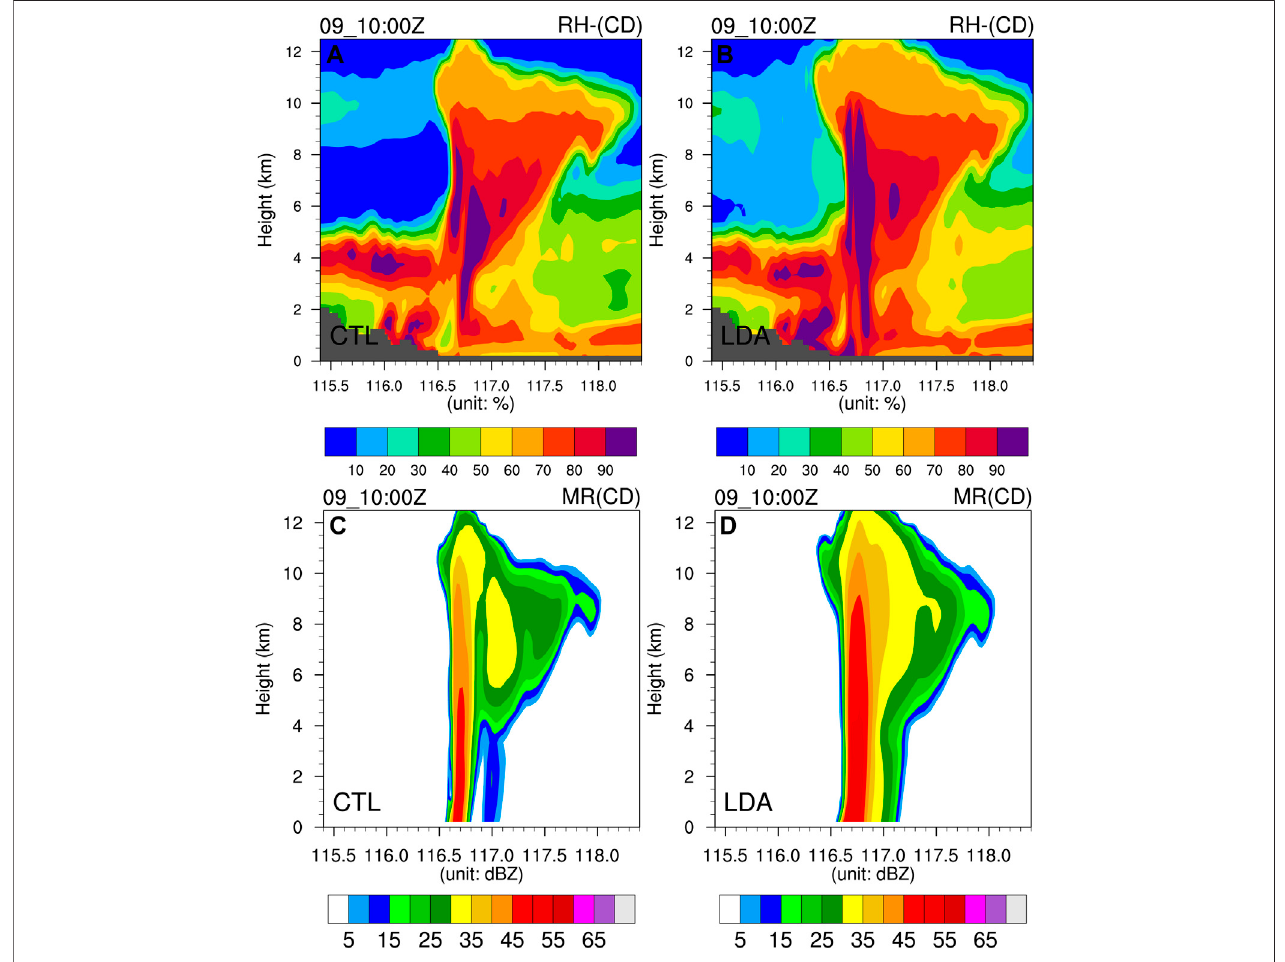
FIGURE 9 | Height vs. position cross-section of (A,B) relative humidity (unit: %) and (C,D) radar re fl ectivity (unit: dBZ) at 1000 UTC 9 August in (A,C) control experiment and (B,D) assimilation experiment.